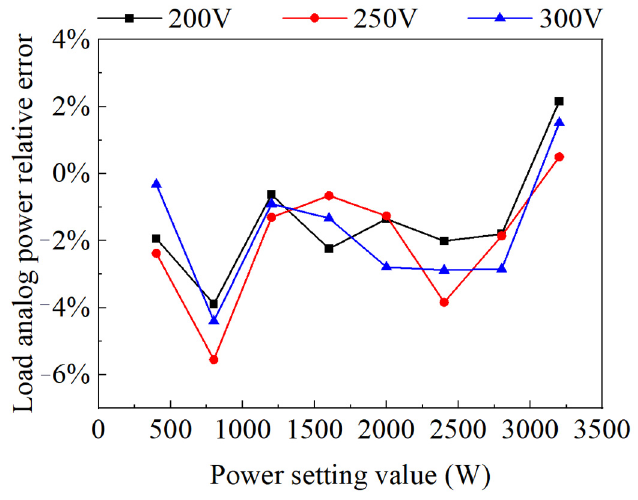
Figure 13. Load simulation power relative error curve.